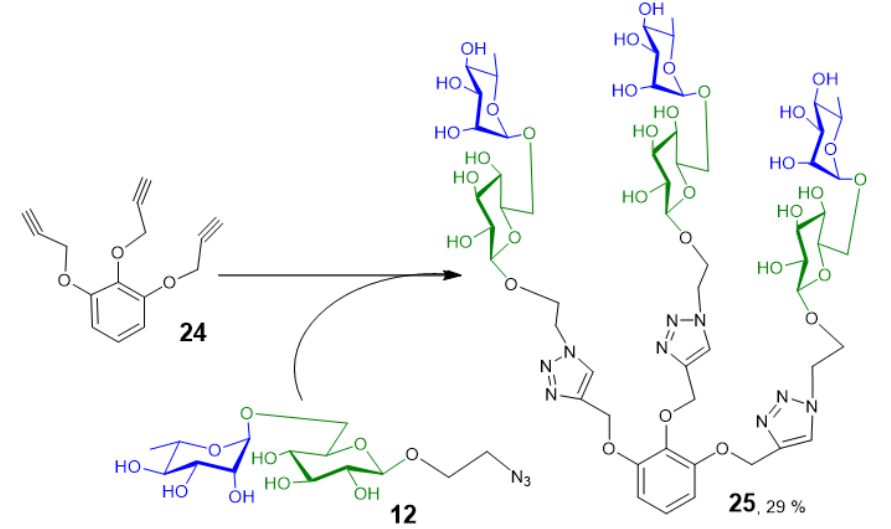
Figure 2. Conjugation of 2-azidoethyl rutinoside ( 12 ) to the trivalent carrier 23 using Cu + -catalyzed azide-alkyne cycloaddition reaction.